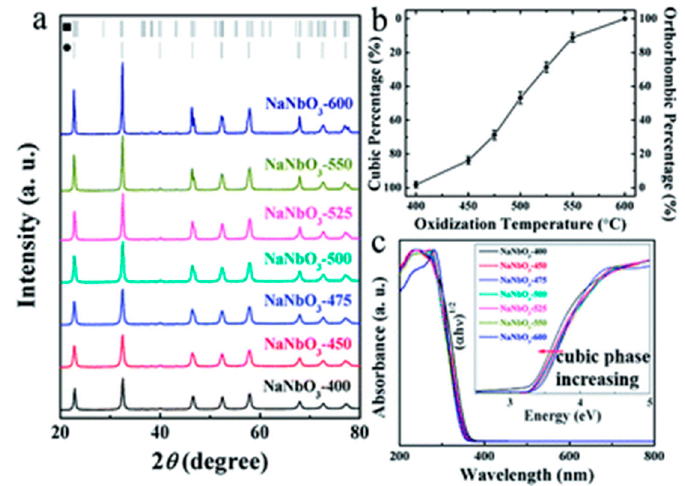
Figure 15. ( a ) X-ray diffraction (XRD) patterns of the as-prepared NaNbO 3 samples. ( b ) Dependence of cubic and orthorhombic NaNbO 3 contents on the annealing temperature. ( c ) UV/vis absorption spectra of the as-prepared NaNbO 3 samples and the inset in the figure is the corresponding ( α h ν ) 1 / 2 –h ν curves. Reproduced with permission from the authors of [89]. Copyright (2019), Royal Society of Chemistry, London, United Kingdom.